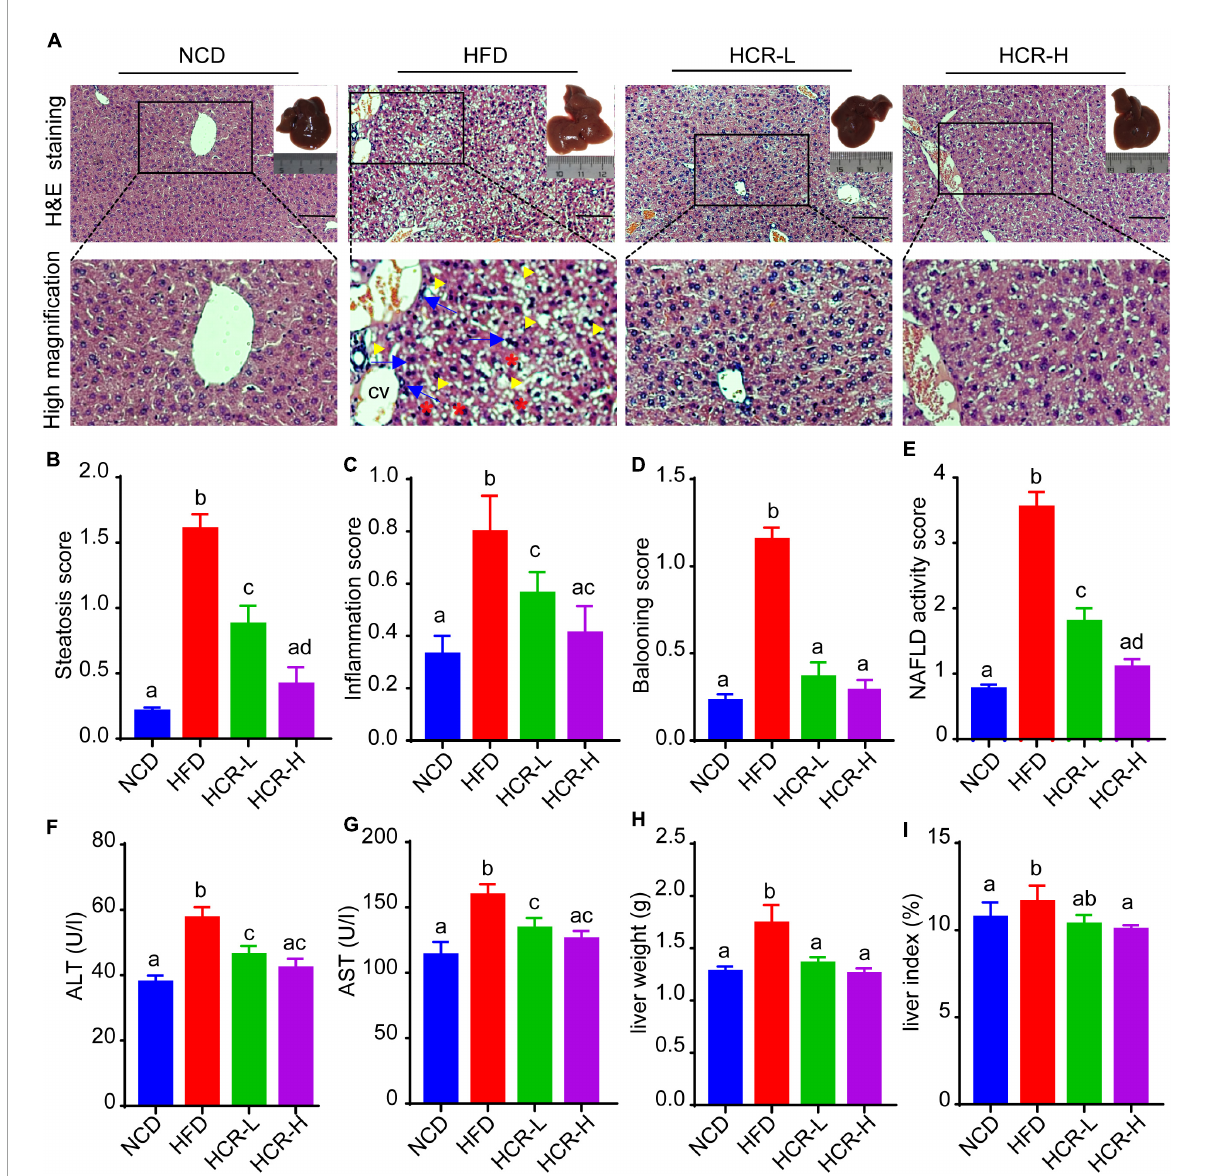
FIGURE1 Cori reduced the high NAFLD activity score (NAS) and inhibited liver damage in HFD-fed mice. (A) H&E staining of livers in indicated groups. As shown in high magnification image of HFD group, arrowhead (yellow color) indicates steatosis; arrow (blue color) indicates inflammatory cells infiltration; asterisk (red color) indicates a balloon-like change; cv indicates central vein. Bar = 50 µ m. Liver gross morphology of indicated group was represented in the upper right corner. (B) Hepatic steatosis score, (C) inflammation score, (D) ballooning score, and (E) NAFLD activity score (NAS) were quantified from indicated groups. (F) Serum ALT and (G) AST levels were measured by biochemical analysis. (H) Liver weights of indicated groups. (I) Liver index (the ratio of liver weight to body weight) in indicated groups. NCD, normal chow diet; HFD, high fat diet; HCR-L, high fat diet plus treatment with low dose of Cori (5 mg/kg/2 days); HCR-H, high fat diet plus treatment with high dose of Cori (10 mg/kg/2 days). Values were means ± SD, and for statistical analysis, one-way ANOVA were performed between indicated